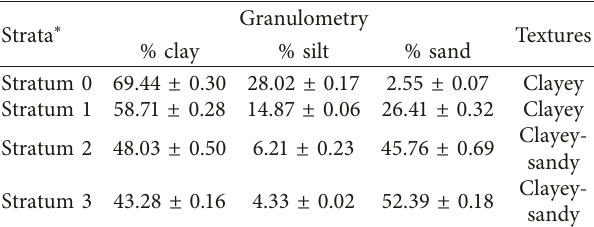
Table 2: Granulometric analysis of the landfill soil of